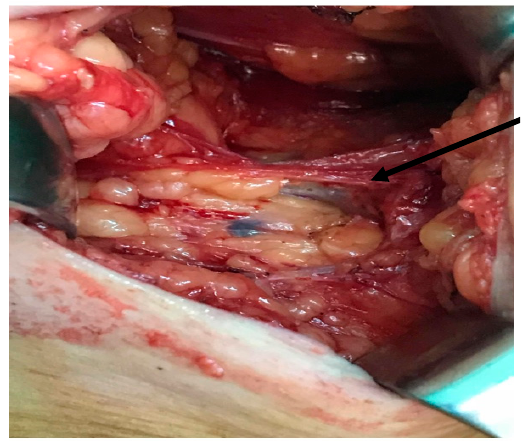
Figure 1. Axillary dissection—ARM node colored in blue .